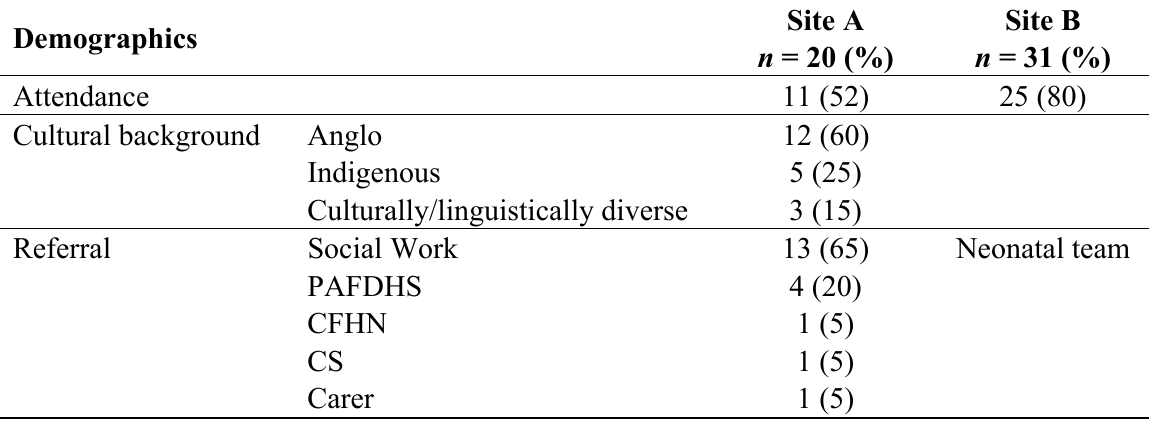
Table 5. Demographic details of clients referred to